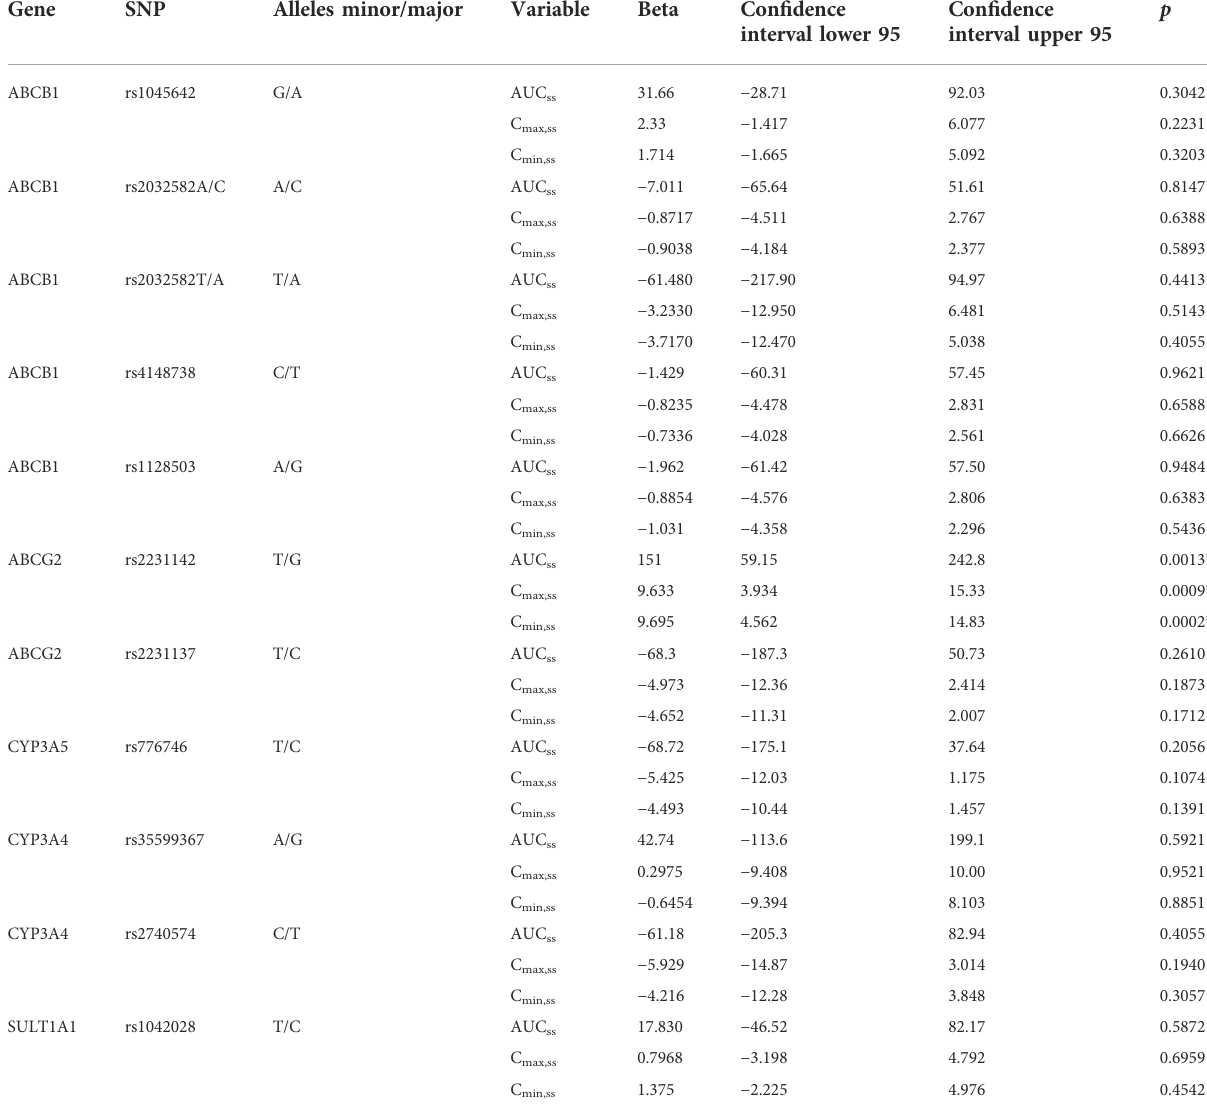
TABLE 4 Association between candidate single nucleotide polymorphisms and AUC ss , C max,ss , and C min,ss . N = 1,325. Gene